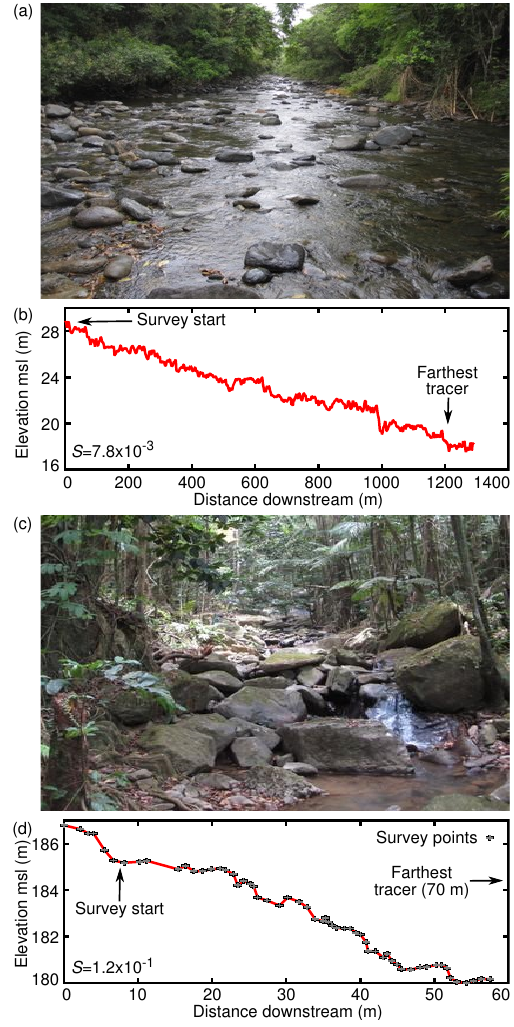
Figure 3. (a) Photograph of the main channel of the Mameyes River looking upstream to the location where the tracer particles were in- stalled. The width of the wetted portion of the channel is approxi- mately 20m. (b) Longitudinal profile extracted from a lidar DEM of the main channel of the Mameyes River. S is the slope. (c) Pho- tograph of the Bisley 3 stream looking upstream, showing the lo- cation of the farthest tracer found downstream. The wetted region in the foreground is approximately 2m wide. (d) Longitudinal pro- file from field survey; gray crosses represent the location of survey points. S is the